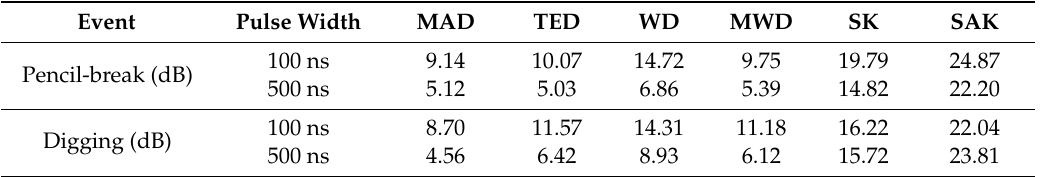
Table 1. The average locating SNRs of each method on the 200 locating tests.